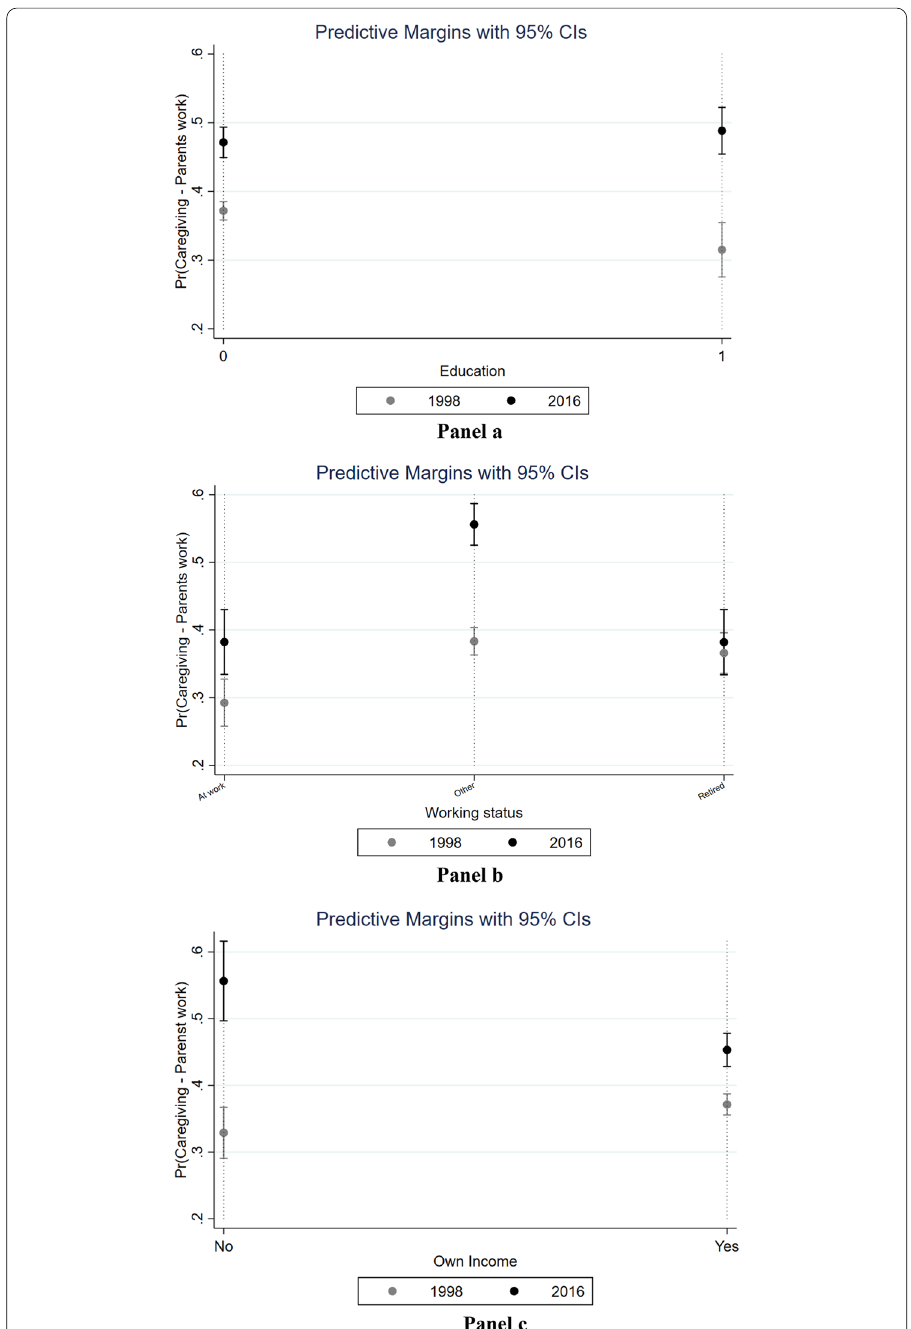
Fig. 4 Predicted probabilities grandchild care when parents work—changes over